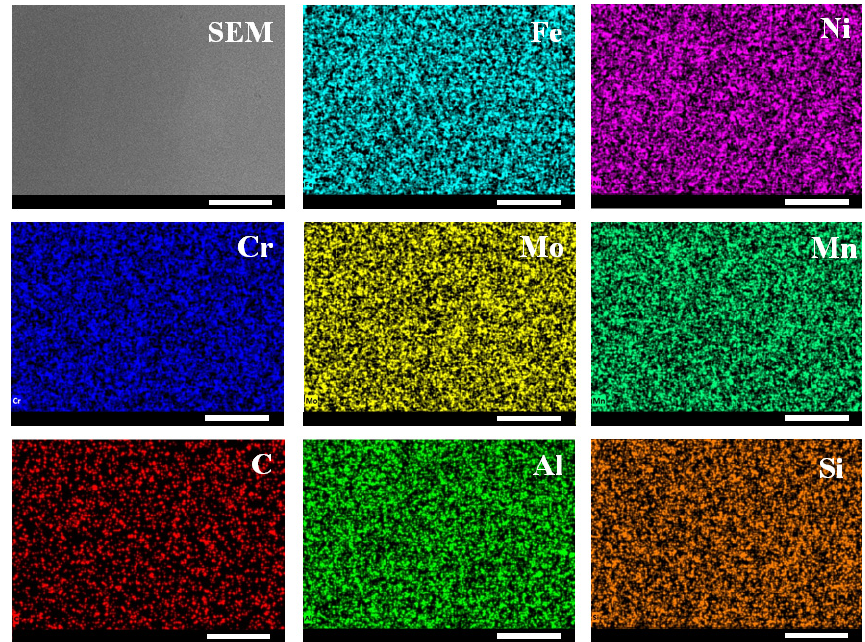
Figure 7. SEM image of the sample and the corresponding EDS images (Scale bar: 100 μ m).